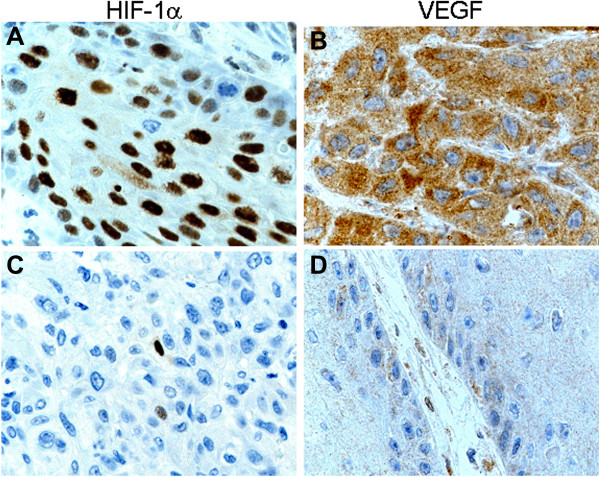
Representative images of HIF-1α and VEGF immunoexpression in primary vulvar carcinoma. (A) high HIF-α nuclear expression and (B) low HIF-α nuclear expression (C) high VEGF cytoplasmic staining and (D) low VEGF cytoplasmic staining. 40× objective lens.